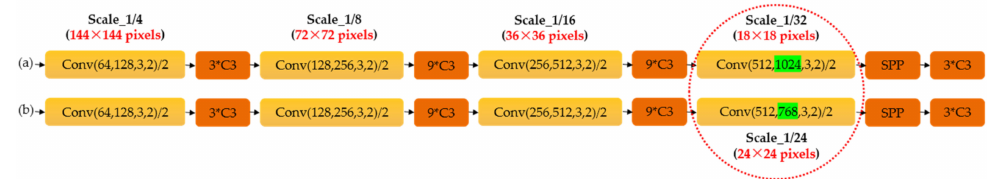
Figure 3. The backbone network before ( a ) and after ( b )